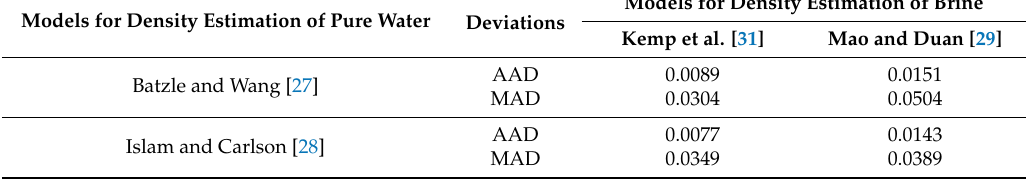
Table 3. Deviation of various model estimations for the CaCl 2 –H 2 O system from the experimental data measured by Al Ghafri et al. [30]. AAD is average absolute deviations and MAD is maximum absolute deviations of model (see below) estimates from experimental measurements conducted in current study.